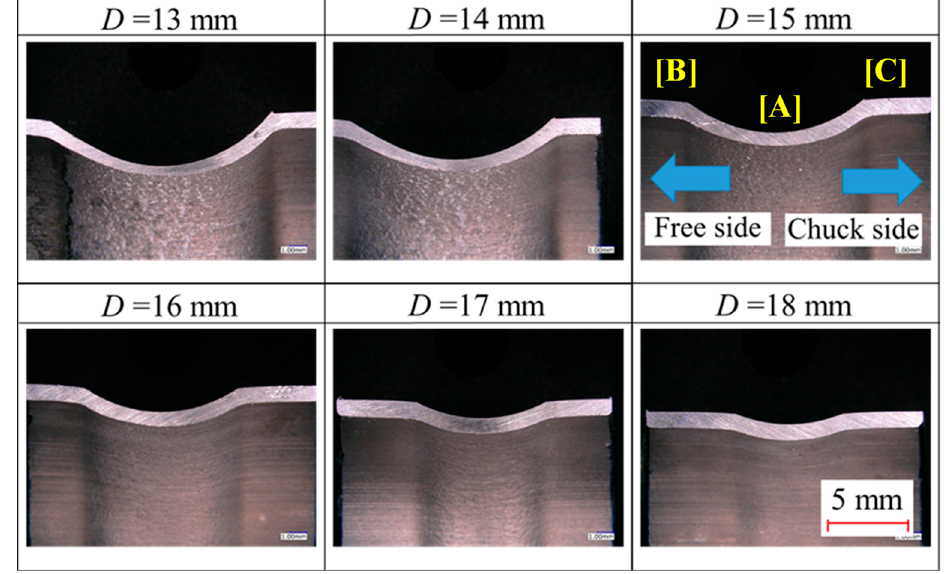
Figure 14. Cross-section of the tube (ball diameter Φ b = 15.9 mm, pushing pitch f R = 0.042 mm/rev). Table 4. The thickness increasing ratio η .